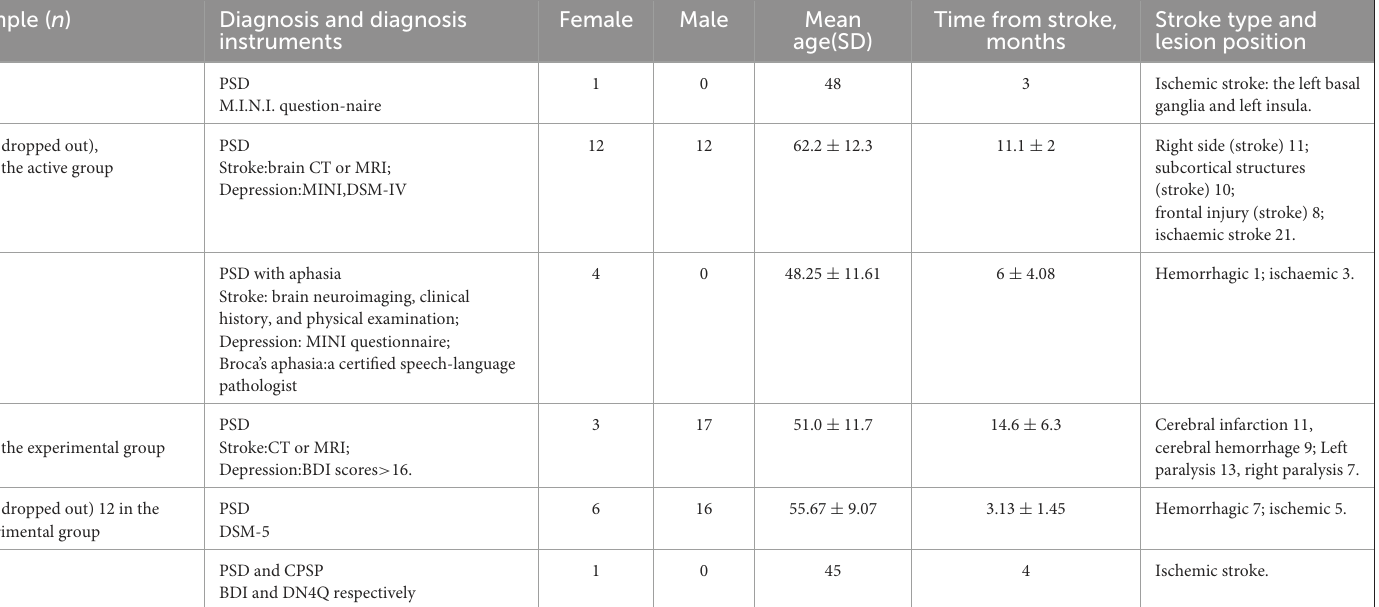
TABLE 2 Summary of the participant’s characteristics in the active/experimental